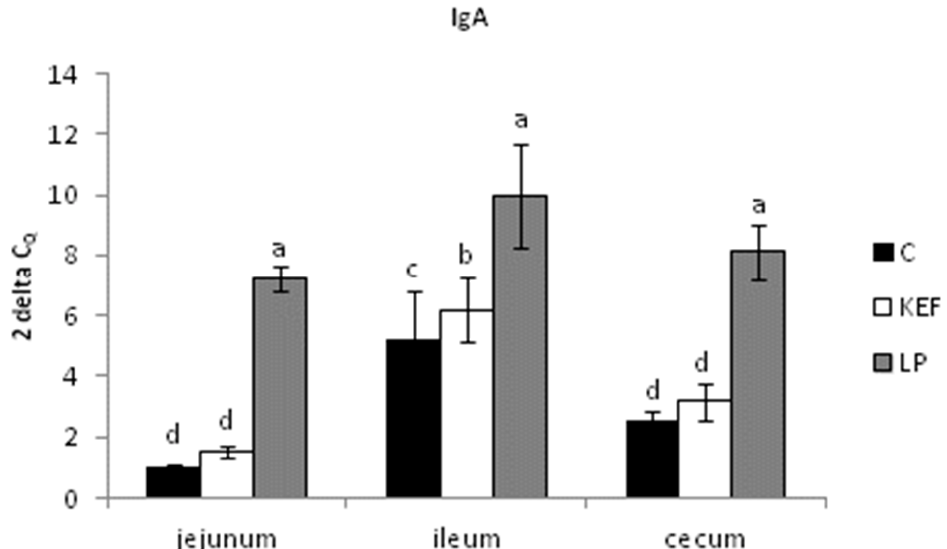
Figure 4. Relative expression level of IgA (jejunum, ileum, cecum) in mice ( n = 6). Results at each timepoint are the median of 2 – ∆ Cq . Means with different superscripts in individual intestinal segments are significantly different. ab p < 0.05; ac p < 0.01; ad p < 0.001.